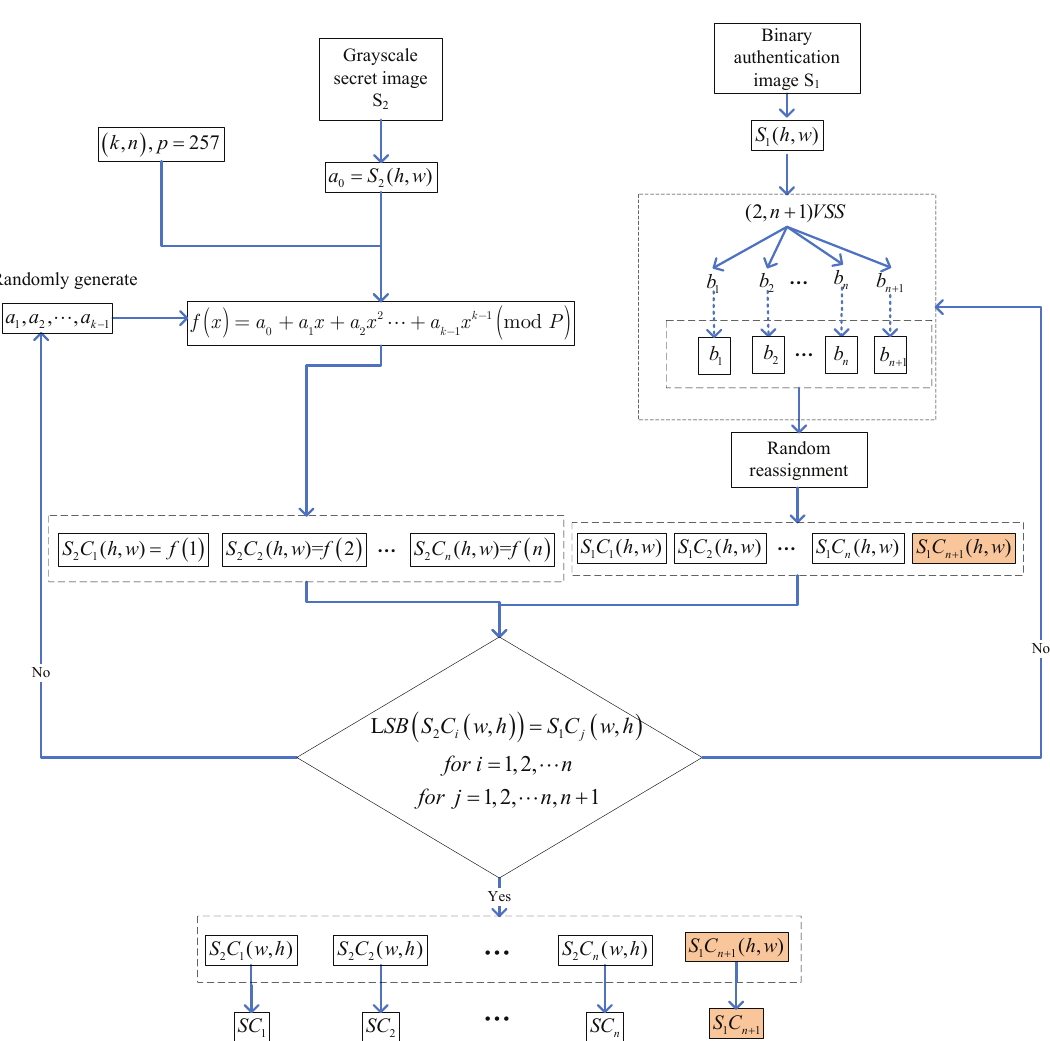
Figure 3. Design mentality of the proposed secret image sharing with dealer-participatory and non-dealer-participatory mutual shadow authentication